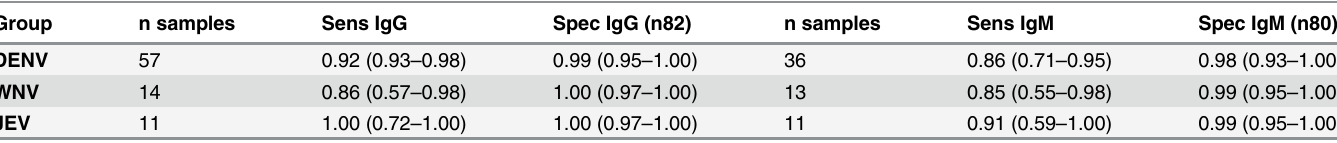
The number of positive samples are indicated in column ‘ n samples ’ and the number of negative samples are shown behind brackets in the ‘ Spec ’